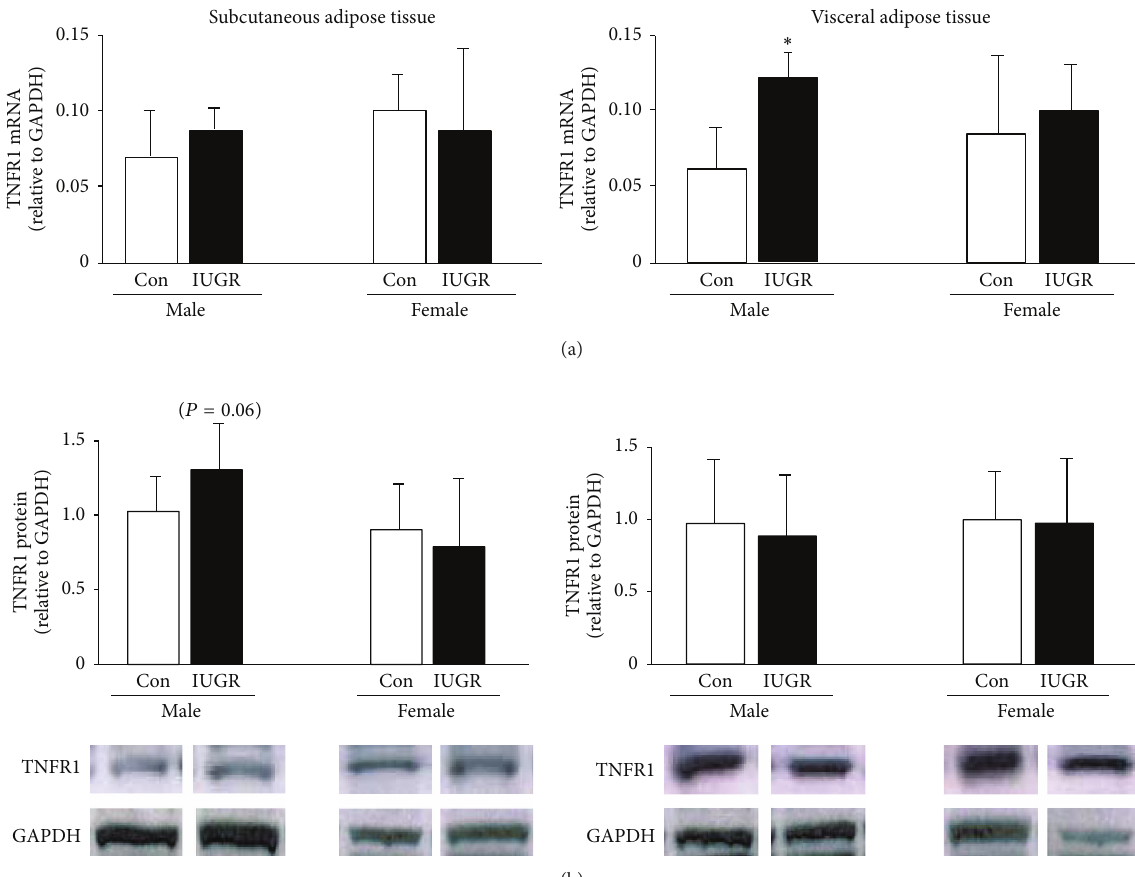
Figure 3: TNFR1 mRNA and protein levels. IUGR increases visceral TNFR1 mRNA levels in male rats. Results are control (white bars) and IUGR (black bars). Errors are SD. 𝑛 = 6 , ∗ 𝑃 ≤ 0.05